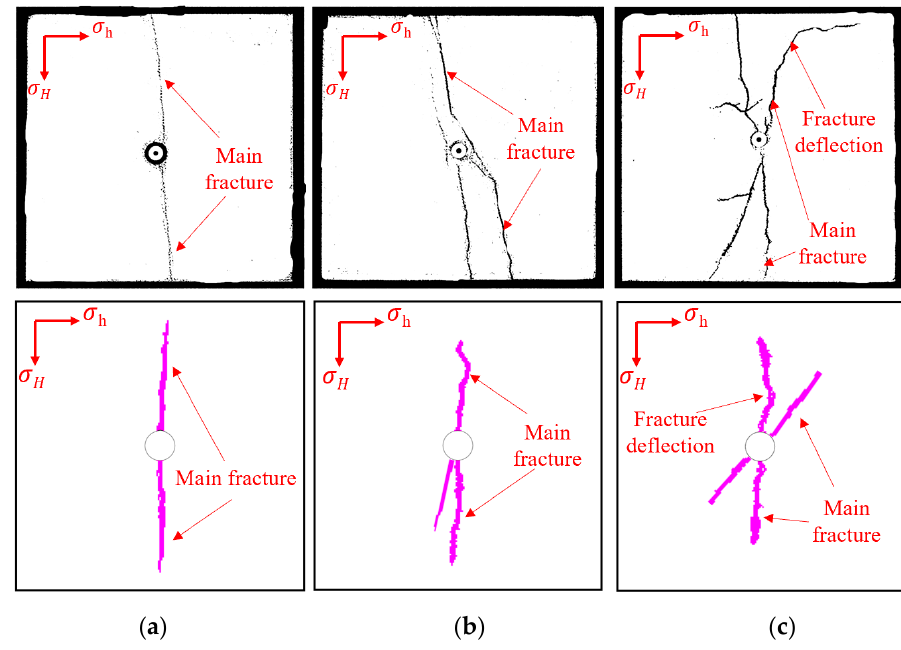
Figure 10. The comparison between experimental observations and numerical simulation results when injecting various fluids. ( a ) water; ( b ) liquid carbon dioxide; ( c ) supercritical carbon dioxide.